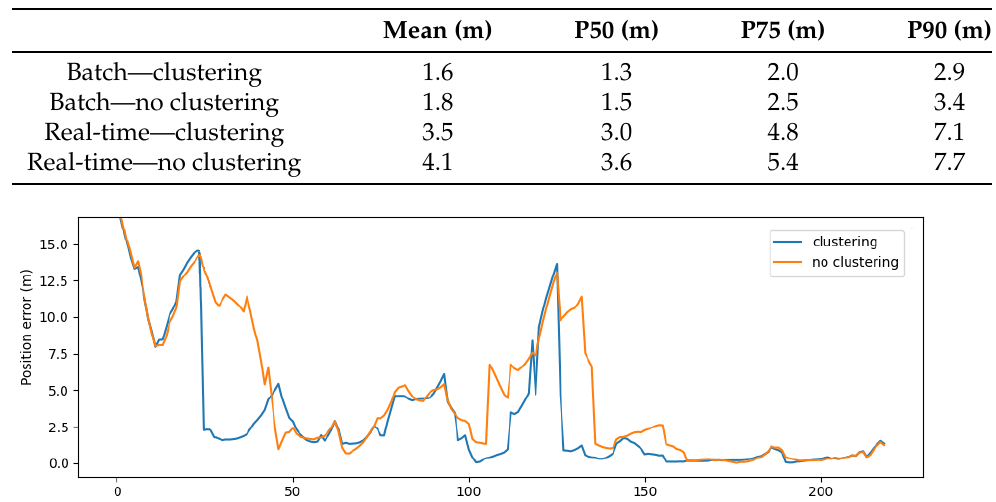
Figure 10. Error CDFs of the backtracking particle filter algorithm in real-time and batch mode. ( a ) Comparison between localisation with and without clustering, for all trajectories. Floor transition detections and the WiFi RSS were used as measurement updates in the BPF algorithm for each configuration. ( b ) Comparison between using floor transition detections as measurement updates in the BPF algorithm and not using the transition detections, for all multifloor trajectories. The proposed clustering algorithm was enabled, and the WiFi RSS was used as the measurement update. Table 6. Error statistics of the backtracking particle filter algorithm with and without clustering, in real-time and batch mode.